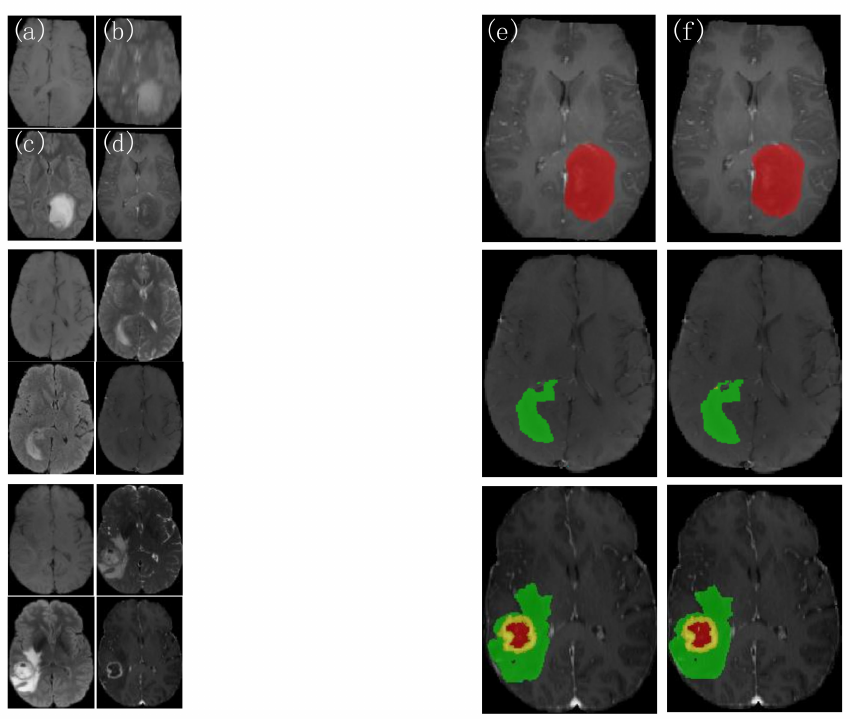
Figure 6. Comparison of the actual segmentation of the 3D BCS_T model tumors in different patients. ( a ) T1 images; ( b ) T2 images; ( c ) FLAIR images; ( d ) T1ce images; ( e ) 3D BCS_T images; ( f ) GT